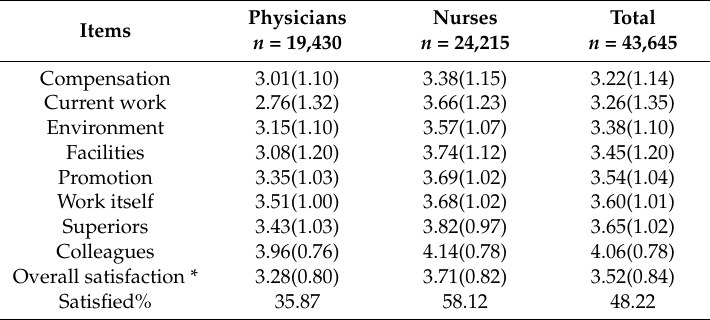
Table 4. Job satisfaction of respondents, mean